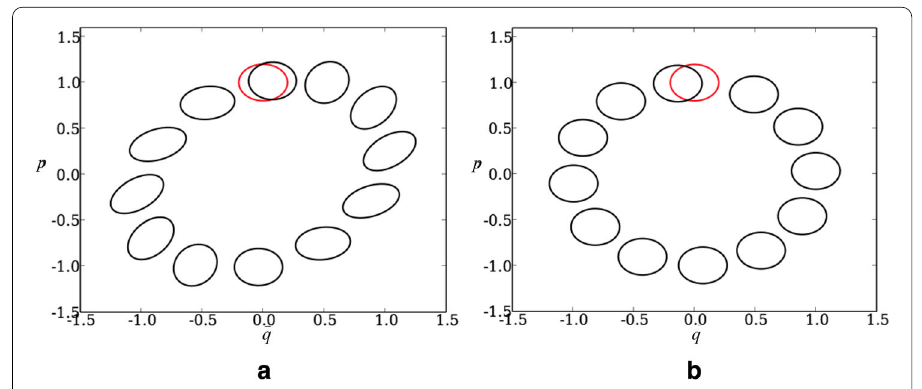
Fig. 4 Harmonic oscillator. Evolution of a disc (in red at t = 0) with symplectic Euler-type integrators. a